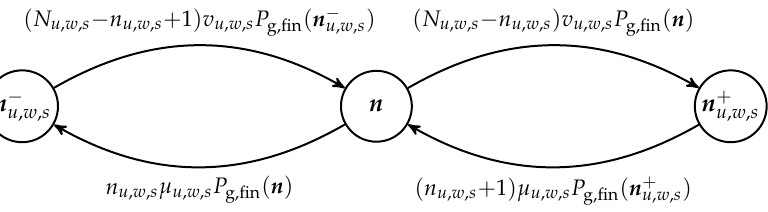
Figure 10. The generalized f-MC-MC model.